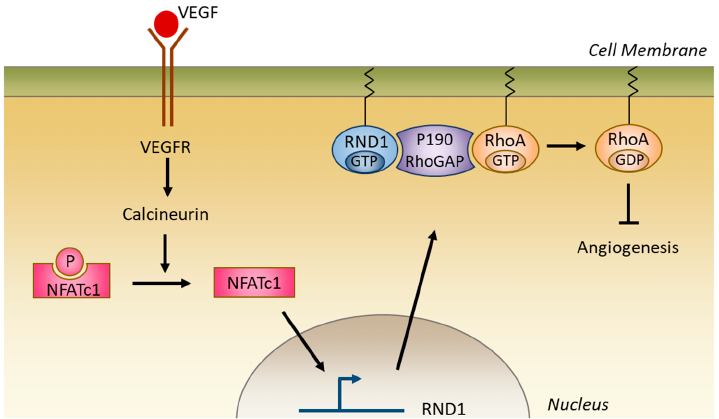
Figure 6. RND1 limits angiogenesis. Vascular endothelial growth factor (VEGF) activates calcineurin- RND1 limits angiogenesis. Vascular endothelial growth factor (VEGF) NFATc1 signaling axis. Nuclear localized NFATc1 binds to the RND1 promoter and stimulates its